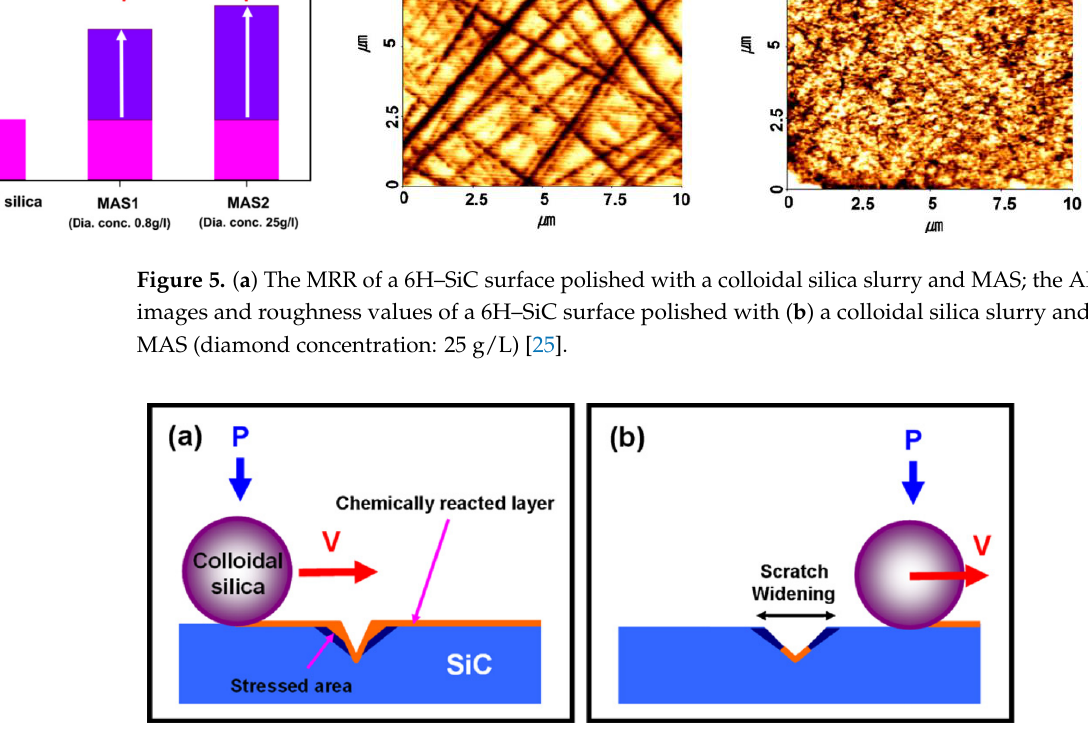
Figure 6. Probable mechanism of scratch removal in colloidal silica slurry CMP: ( a ) chemically reacted surface of SiC; ( b ) the SiC surface after chemically reacted layer removed by colloidal silica [26].